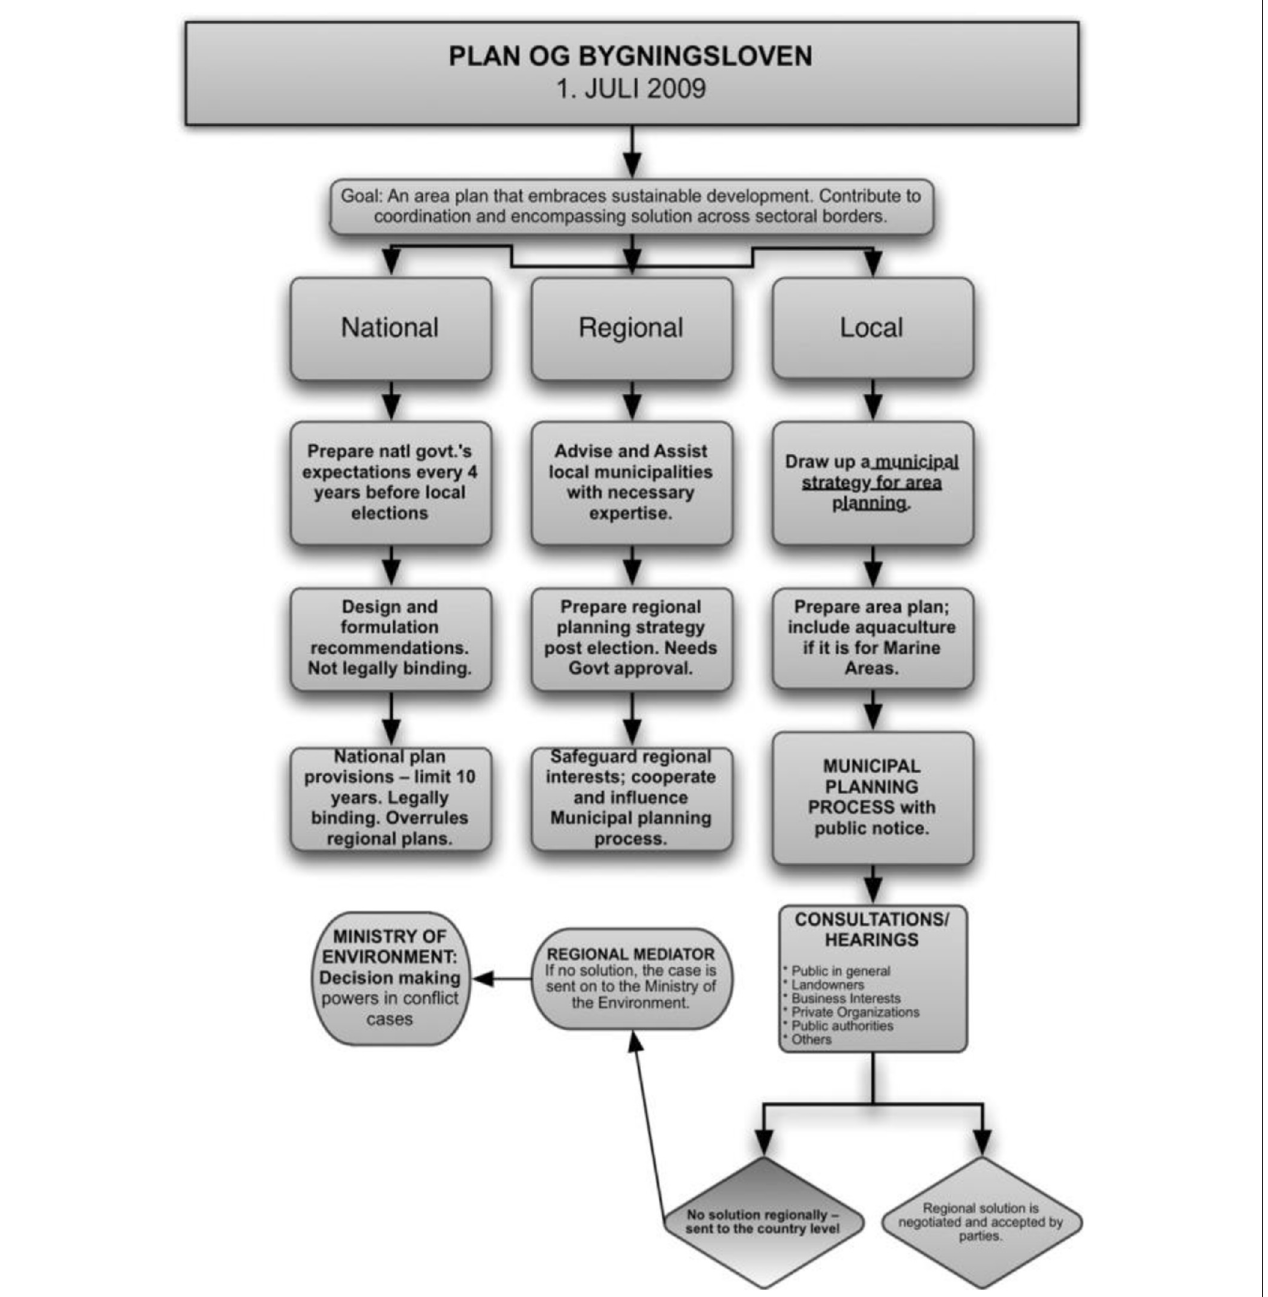
FIGURE 1 | Planning and Building Act